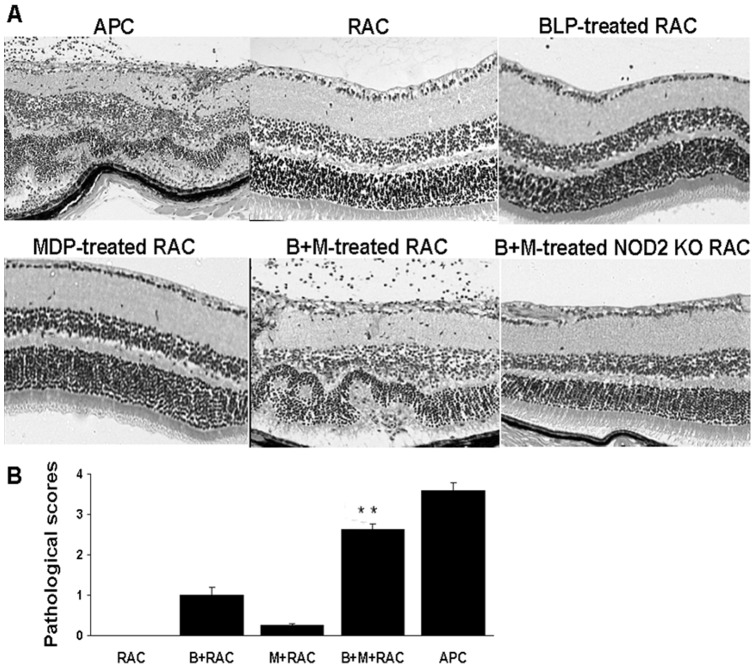
BLP and MDP pre-treated RACs enhance the disease-inducing ability of IRBP-specific T cells.IRBP1–20-specific T cells from the draining lymph nodes and spleens of donor B6 mice immunized with IRBP1–20 were stimulated with IRBP1–20 and irradiated naïve splenic APCs or RACs from either wild-type B6 or NOD2 knockout mice that had been left untreated or had been pre-treated with BLP and/or MDP as described in Fig. 2, then the T cell blasts (5×106 cells/mouse) were transferred to naïve mice (n = 6/group). Eyes from the recipient mice were collected for histological evaluation on day 18 post-transfer. Histopathological lesions in the eyes of one representative mouse in each group (A) and average disease scores of both eyes in 6 individual mice that received T cells (B) are shown. **p<0.01 compared with RAC treated with medium, BLP, or MDP alone using Mann-Whitney U test.